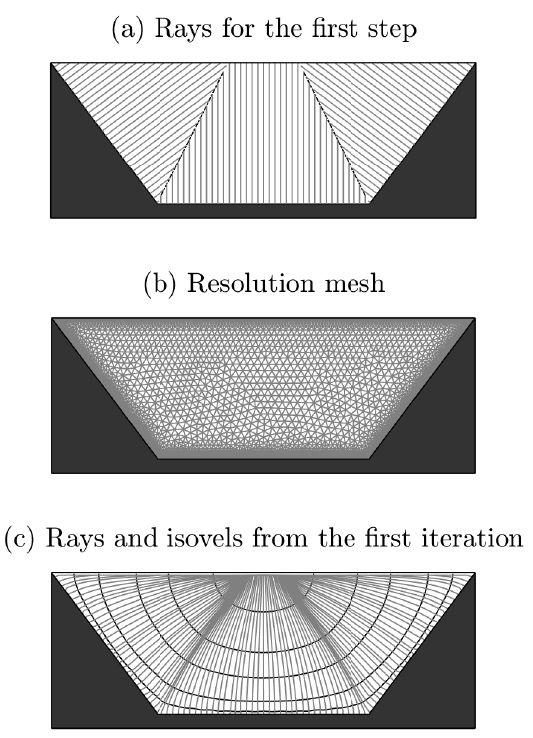
Figure 3. ( a ) Rays for the first step using the MPM variation; ( b ) mesh used for the trapezoidal case; and ( c ) Rays and isovels using the velocity distribution obtain from the first